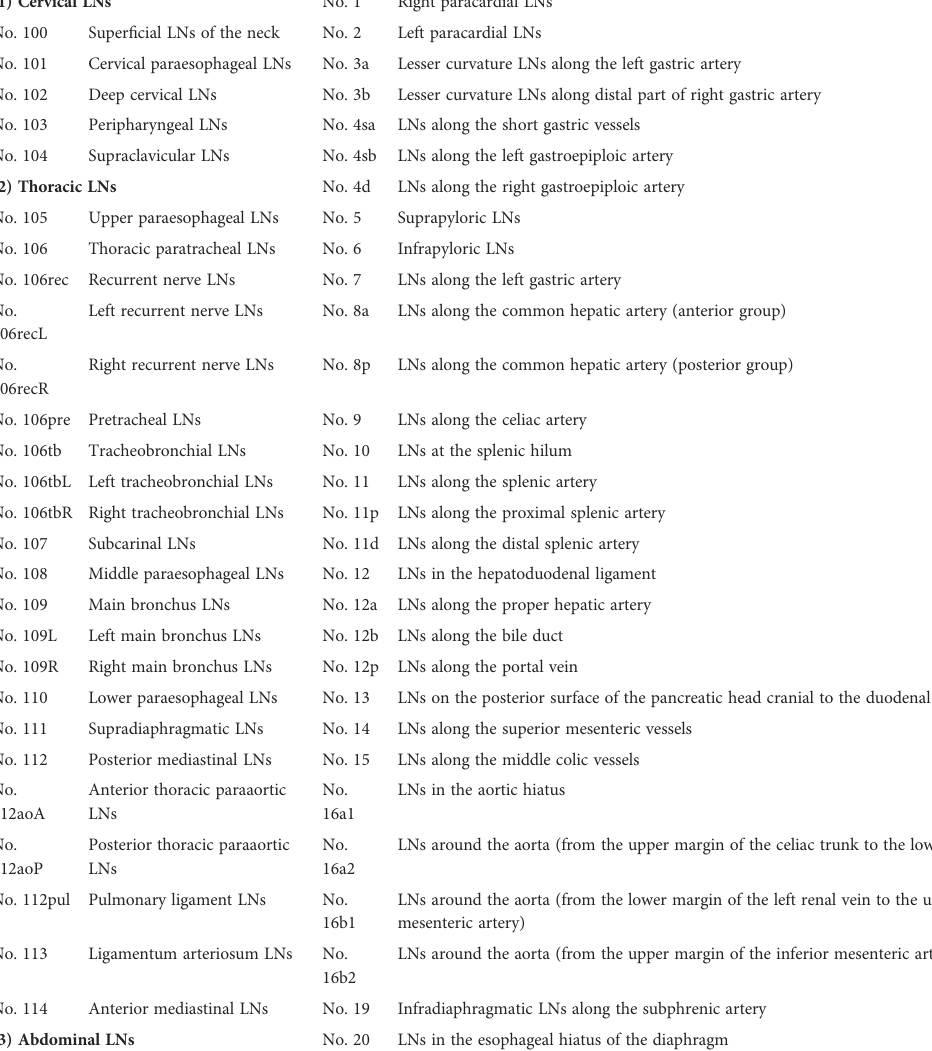
TABLE 1 The stations of regional lymph nodes from EGJ cancer.